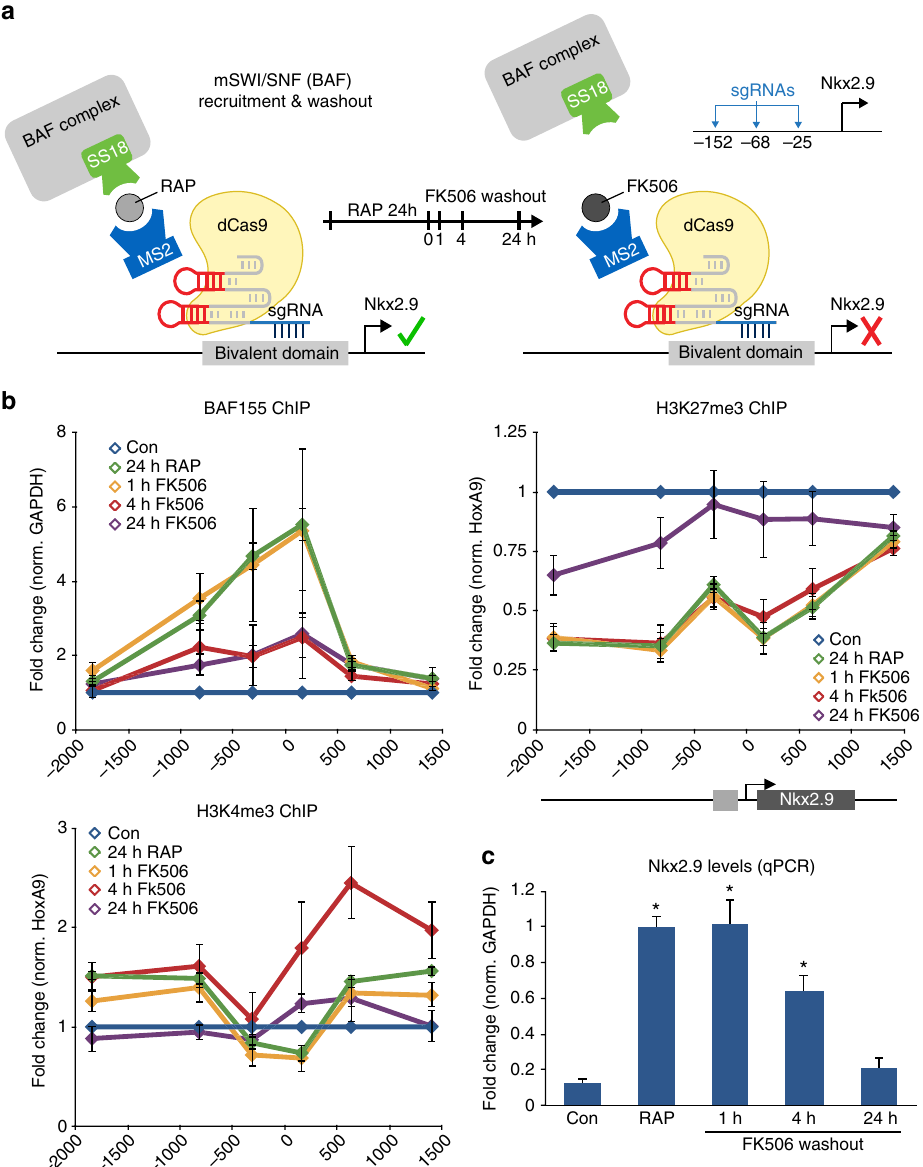
Fig. 4 Transient BAF-dependent activation of Nkx2.9 does not form a stable epigenetic memory a Schematic representation of BAF complex recruitment with SS18-Frb (+RAP) and subsequent removal (+FK506) at the Nkx2.9 locus in mESCs b Rapid BAF washout studies by FK506 treatment performed for 1, 4, and 24 h post 24 h recruitment (+RAP) to the Nkx2.9 locus. BAF155 ChIP shows a loss of this subunit of the complex over the recruitment site after 4 h of SS18-Frb washout. ChIP experiments show an increase in H3K27me3 levels over the bivalent domain after 24 h FK506 treatment, whereas H3K4me3 levels decrease. n = 4; error bars s.e.m. c Nkx2.9 expression levels measured by qPCR during the time course of BAF removal. n = 4; error bars s.e.m. p <